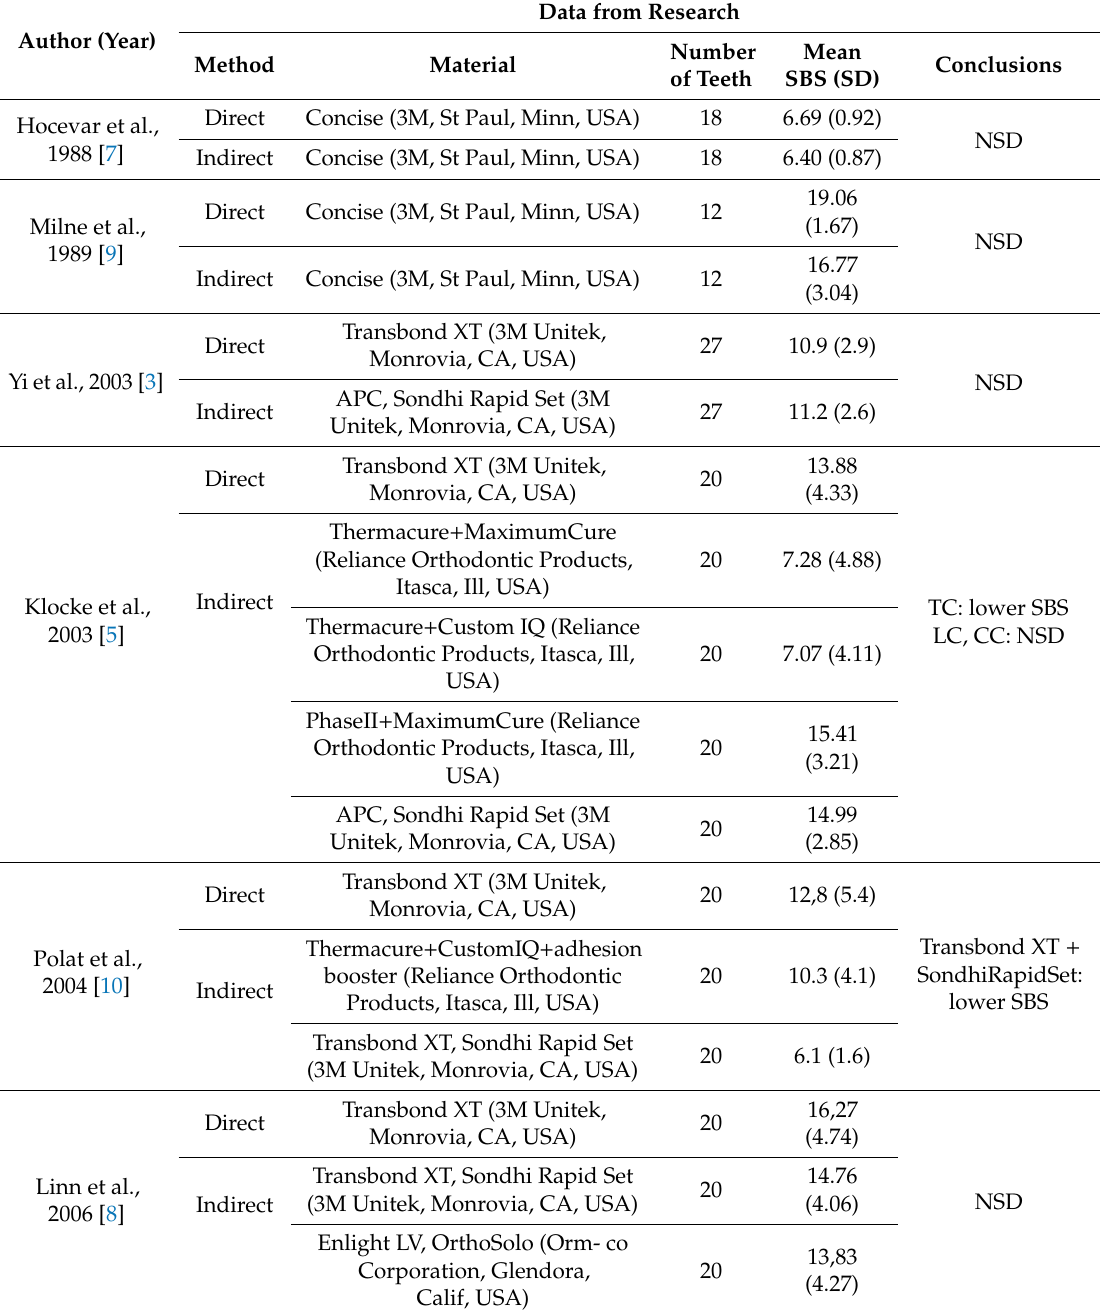
Table 1. Mean shear bond strength (SBS) of di ff erent materials used in the indirect bonding